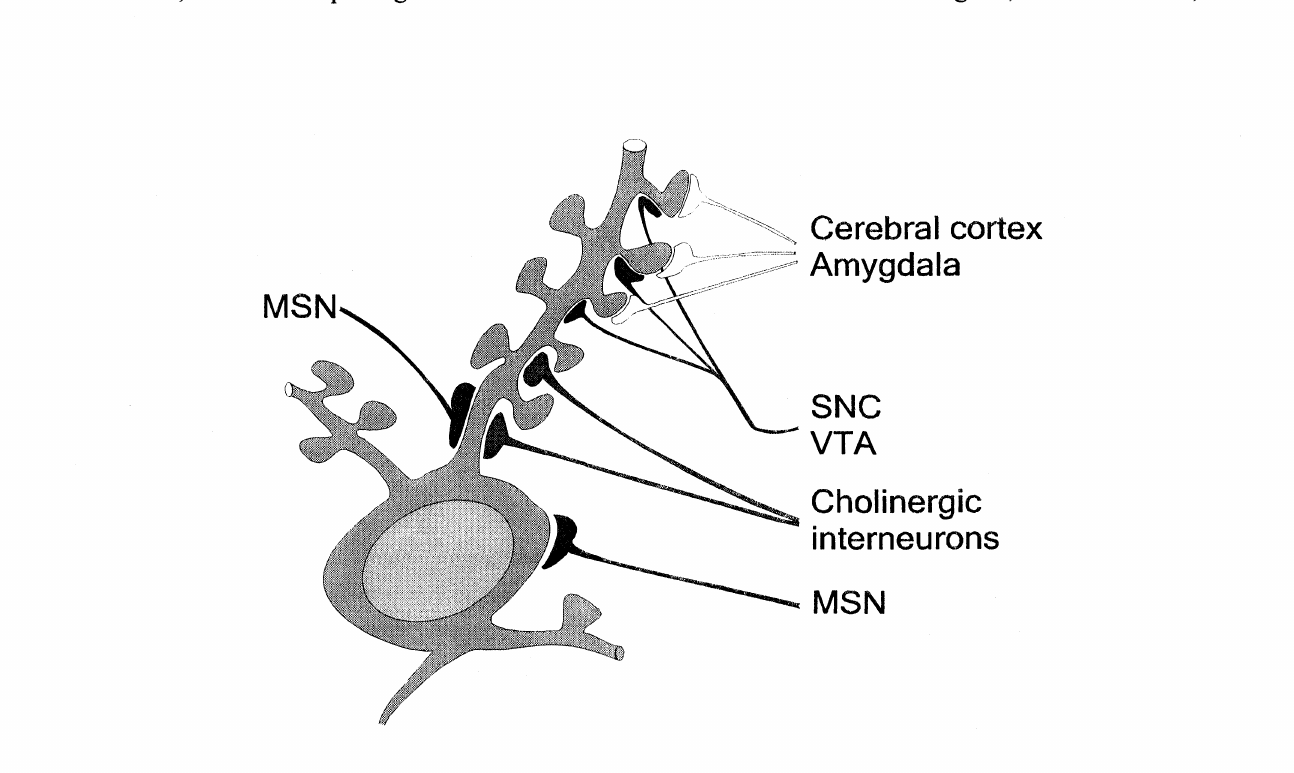
Fig. 1" Schematic representation of a medium-sized spiny neuron (MSN) in the striatum. The position of different inputs on the neuron are indicated: excitatory cortical or amygdaloid inputs end on the head of spines, dopaminergic terminals from the substantia nigra pars compacta (SNC) and ventral tegmental area (VTA) terminate in close association with the corticostriatal inputs on the spine necks or dendritic shafts. Inputs from neighboring medium-sized spiny neurons and striatal interneurons terminate on the proximal parts of the dendrites. Adapted from Smith and Bolam